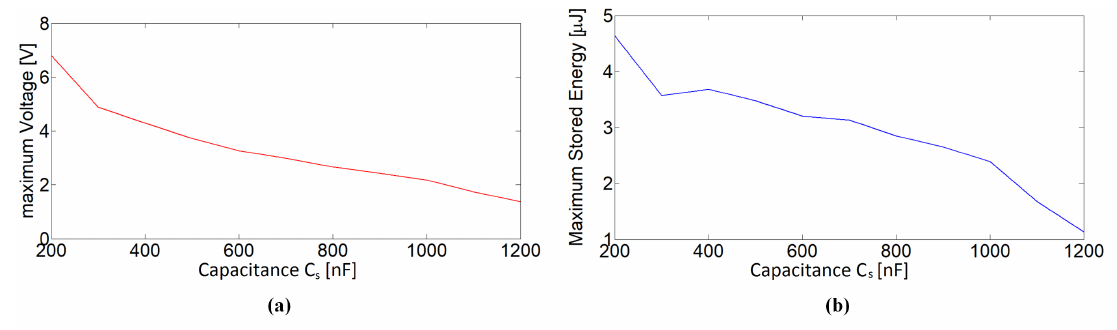
Figure 14. Voltage measured across the storage capacitor 0.2s after the snap ( a ). Stored energy calculated 0.2s after the snap ( b ).